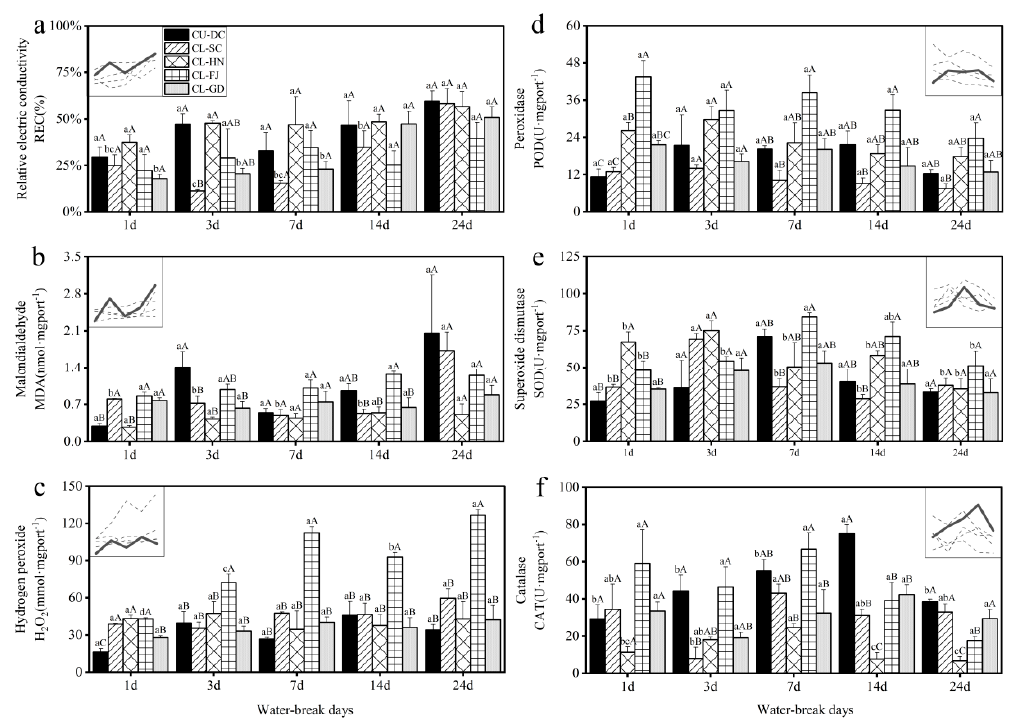
Figure 4. ( a ) relative electric conductivity ( REC ), ( b ) malondialdehyde ( MDA ), ( c ) hydrogen peroxide (H 2 O 2 ), ( d ) peroxidase ( POD ), ( e ) superoxide dismutase ( SOD ) and ( f ) catalase ( CAT ) of C. unica and C. lanceolata leaves under different water − break days.